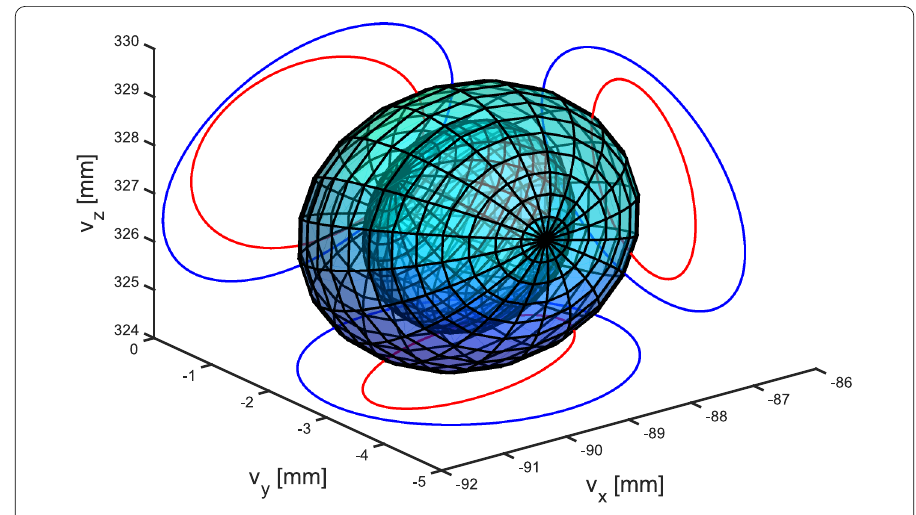
Figure 7 Error ellipsoid defining the linearized 95% confidence region of the tool center point (TCP) of the working configuration. Error ellipsoid defining the linearized 95% confidence region (with χ 2 3 (0.95) = 7.815) of the TCP of the working configuration of a KUKA KR15 with its two dimensional projections resulting from heuristic q h and optimized q s measurement configurations used in parameter identification. The center of the ellipsoid is the TCP position with its parameter values presented in Table 3. The half-axes v x , v y , v z of the confidence ellipsoids are the eigenvalues of the covariance matrices C s ( q h ) (blue) and C s ( q s ) (red) with q s := min q tr( C s ( q